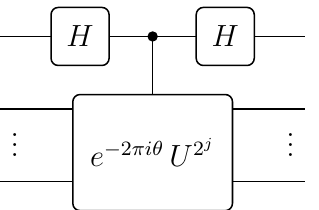
FIG. 9. The quantum circuit used to evaluate ϕ j + 1 at each iteration of the phase estimation-by-QSVT procedure. FIG. 10. A quantum circuit that achieves a unitary block encoding of A j (θ) , which we denote by W j (θ) and incorporate into Algorithm